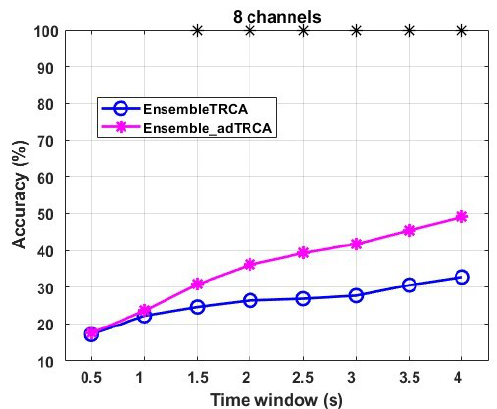
Figure 4. Average Classification in Hairless case for the Speller dataset. The time window ranges from 0.5 s to 4 s (0.5 s interval). * indicates statistically significant difference between the two methods using paired sample t -test ( p <